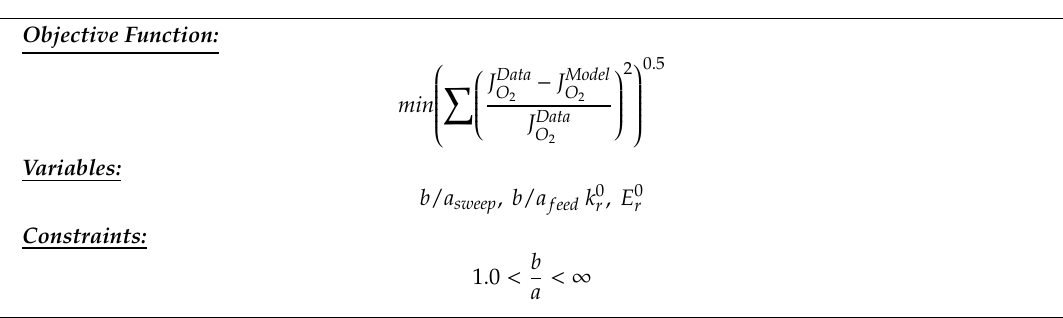
Figure 10. Summary of supported membrane calibration procedure. ( a ) comparison of measured O 2 flux data and model predictions at different operating temperature and sweep flow rate; ( b ) relative error between measured data and model. 5. Heat and Mass Balance of Glass Melting Furnace In this work, we apply the OTM technology to a glass melting furnace. The work by Sardeshpande et al. [5] proposed a model to achieve the minimum specific energy consumption in glass furnaces. Based on field analyses and experimentations in the glass industry, the paper provides the design and operating parameters of a case study representing the current state of the art of glass furnaces. The furnace’s capacity and draw are fixed at 100 ton day − 1 and 90 ton day − 1 , respectively, whereas the cullet fraction is set at 40%. Comparing with Beerkens [6], it is possible to appreciate that it is a very efficient benchmark, even considering the actual cullet (40% vs. 50%), as the energy input amounts to 3833 kJ kg − 1 . Starting from the work by Sardeshpande et al. [5], heat and mass balances are estimated with GS, a computer code in-house developed in the past years at the Department of Energy of Politecnico di Milano [43]. The code is a powerful and flexible tool that can accurately predict the performance of a wide variety of chemical processes and power generation systems. GS was originally designed to assess the performance of gas-steam cycles for power production [44] and has been progressively developed and improved to calculate complex systems including coal gasification, chemical reactors, fuel cells and essentially all the processes present in advanced plants for power generation [45–48]. When addressing the new oxy-fuel furnace solutions, the detailed membrane model, as previously